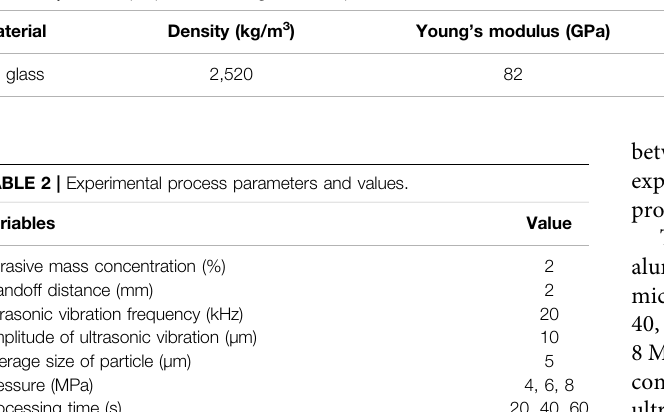
TABLE 1 | Material properties of K9 glass for experiment.